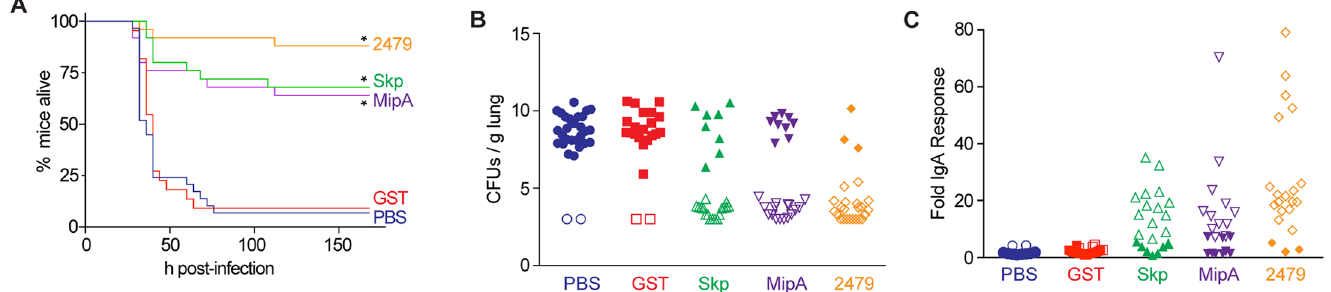
Fig 3. Intranasal challenge. A. Survival assay. The survival of mice is plotted as a function of time after mice were inoculated with ETEC H10407 following immunization with the indicated antigens. Asterisks indicate significant difference in survival, log-rank test, n = 22-29/group. B. ETEC loads (CFUs/g lung) in mice infected with ETEC H10407 at euthanasia or at the end of the study (7 d). Open symbols indicate mice that survived for the duration of the study. Closed symbols indicate mice that were euthanized due to their display of clinical signs of illness, n = 22-29/group. C. Fold change in mouse fecal IgA concentrations, n = 22-29/group, after inoculation with ETEC H10407 following immunization with the indicated antigens. Open symbols indicate mice that survived for the duration of the study. Closed symbols indicate mice that were euthanized due to their display of clinical signs of